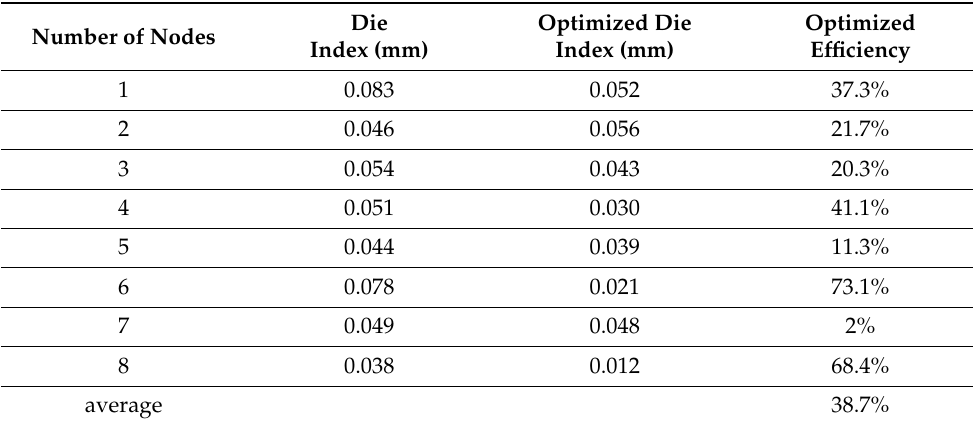
Table 1. Before-and-After Die Index Optimization Comparison Results.